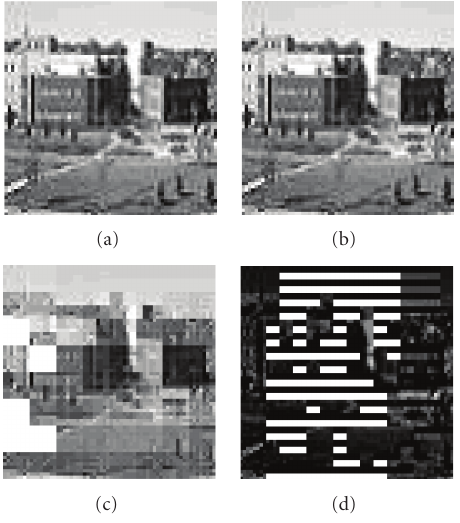
Figure 4: Test image and decoded images. (a) Original “building” image. (b) Correctly decoded image. (c) Blindly decoded image without AES key, for subband selection scheme with 2 blocks of 128-bit AES encryption. (d) Blindly decoded image without AES key, for position-based scheme with 2 blocks of 128-bit AES en- cryption.